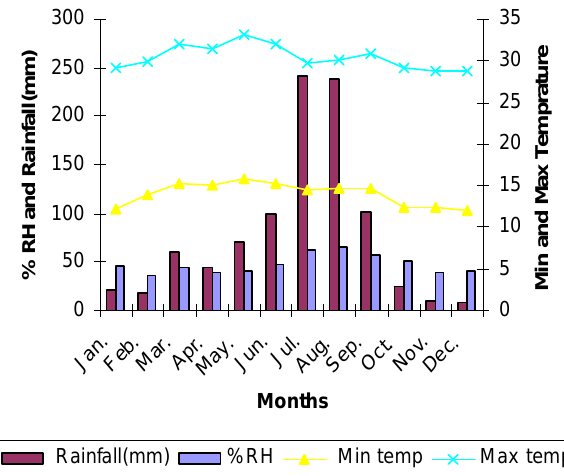
Fig. 2. Monthly mean maximum and minimum temperature ( ◦ C), Figure 2: Monthly mean maximum and minimum temperature ( o C), relative humidity and relative humidity and rainfall (mm) of the Koka Dam (1998– rainfall (mm) of the Koka Dam (1998-2007). (Courtesy: National Meteorological 2007). (Courtesy: National Meteorological Agency, Addis Ababa, Agency, Addis Ababa, Ethiopia)